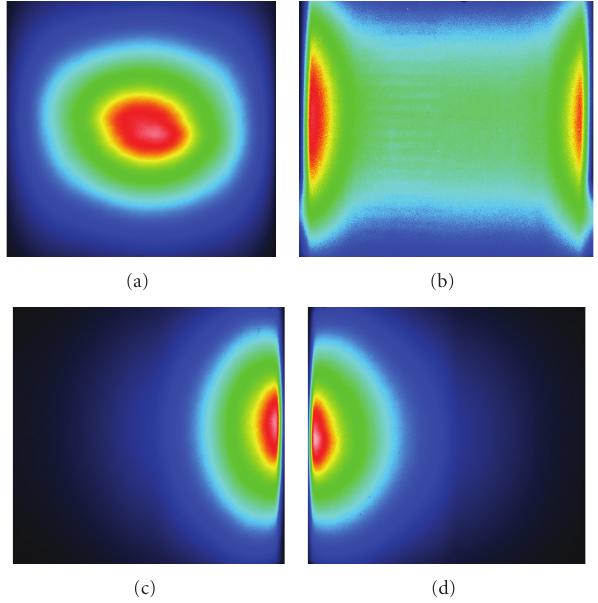
Figure 3: The detected photon energy distribution on the phantom surface by CCD camera.